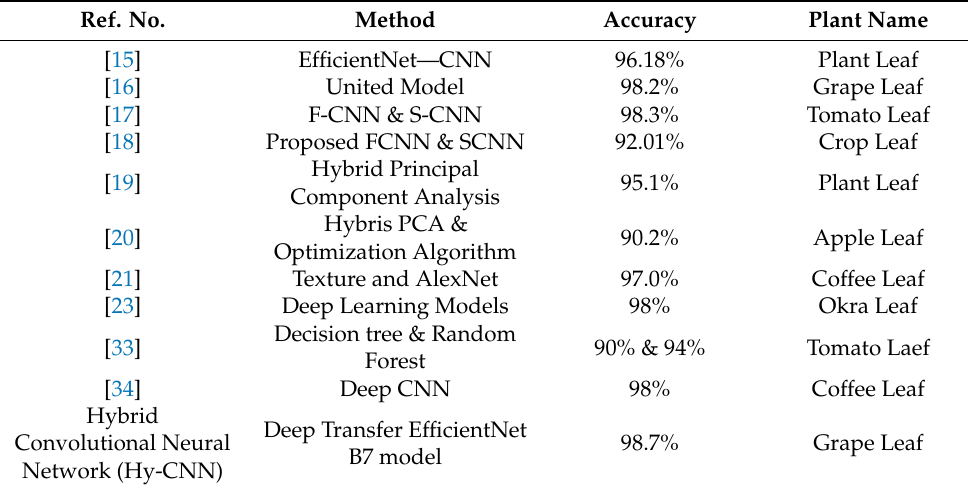
Table 7. Comparison of Hy-CNN model with existing deep learning